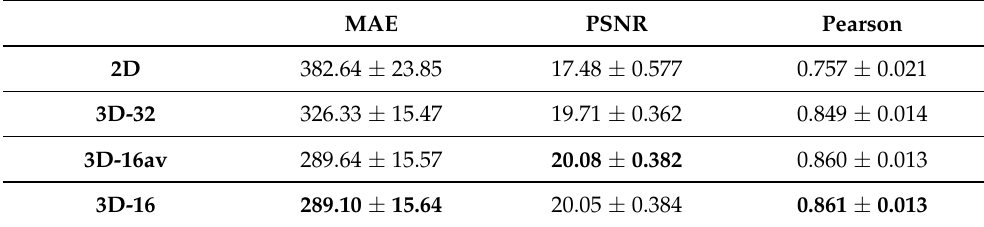
Table 4. Head dataset Bone with U-net. Mean Absolute Error, PSNR and Pearson coefficient within the bone on the head data set obtained using U-net with different convolutions and reconstructions.